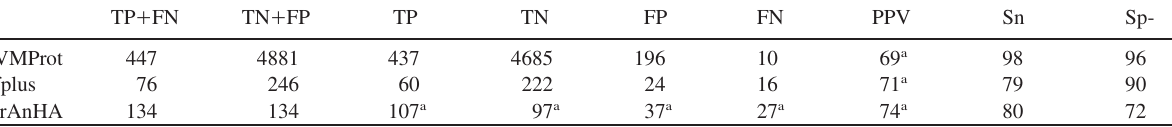
We have used the published data according to: TP, number of correct RNA-binding protein predictions; TN, number of correct non-RNA- binding protein predictions; FP, number of incorrect RNA-binding protein predictions; FN, number of incorrect non-RNA-binding protein predictions; TP q FN, total number of RNA-binding proteins; TN q FP, total number of non-RNA-binding proteins; Sp s (TN/TN q FP) = 100;